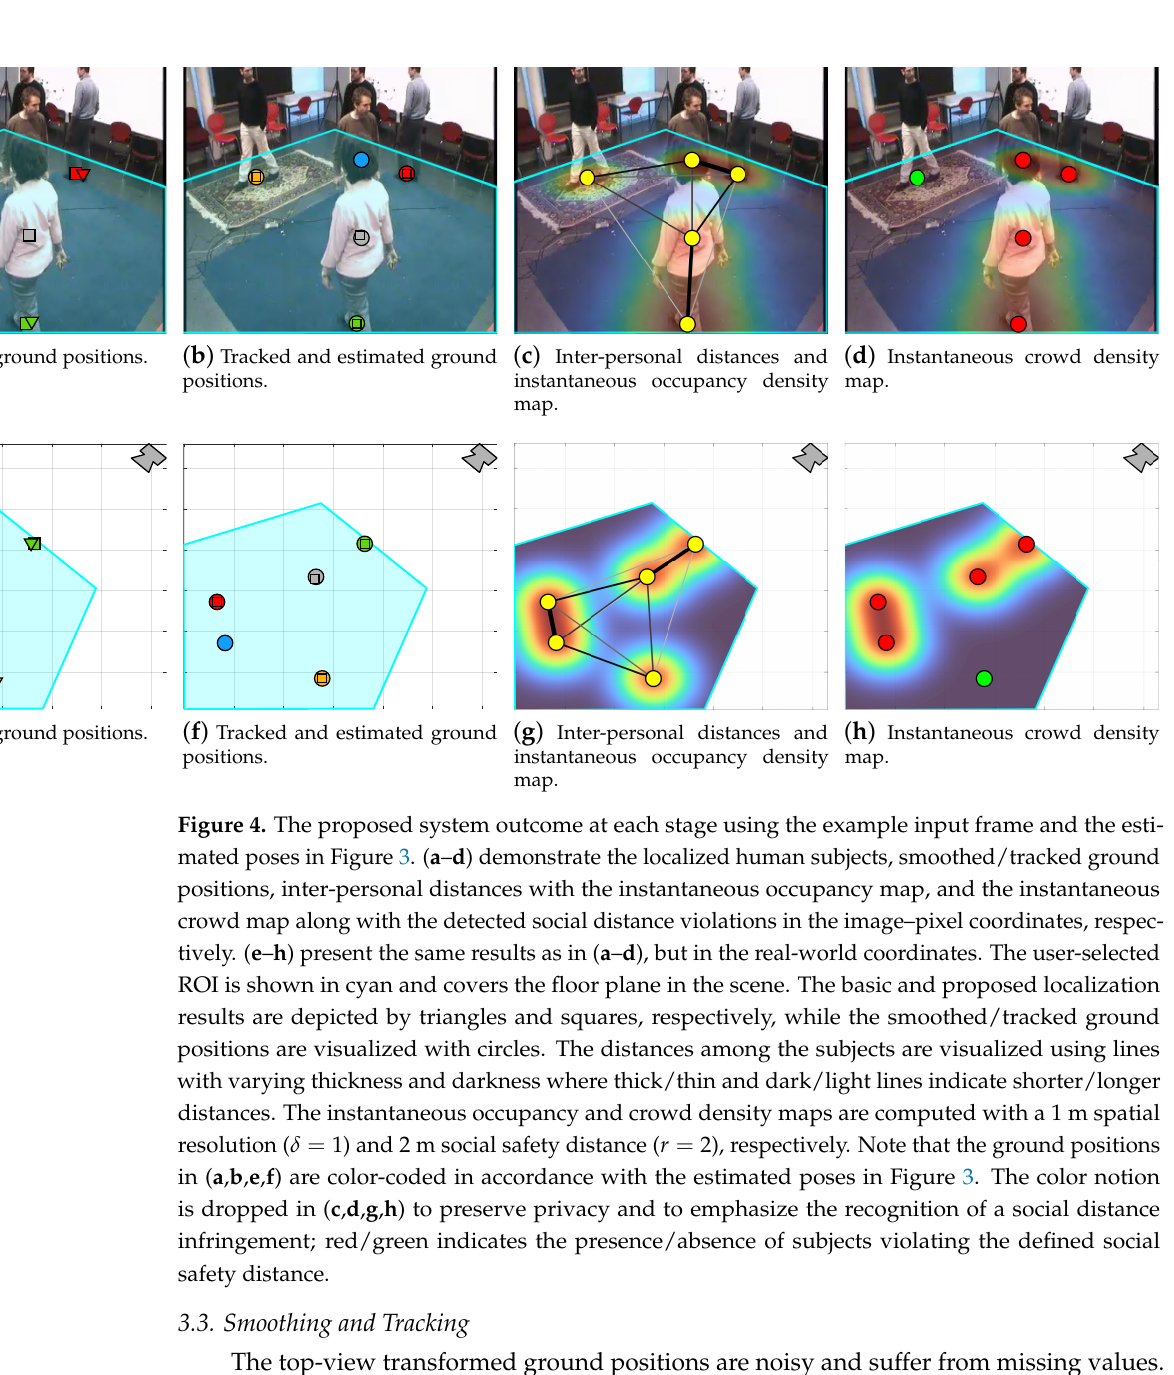
( d ) Instantaneous crowd density map.